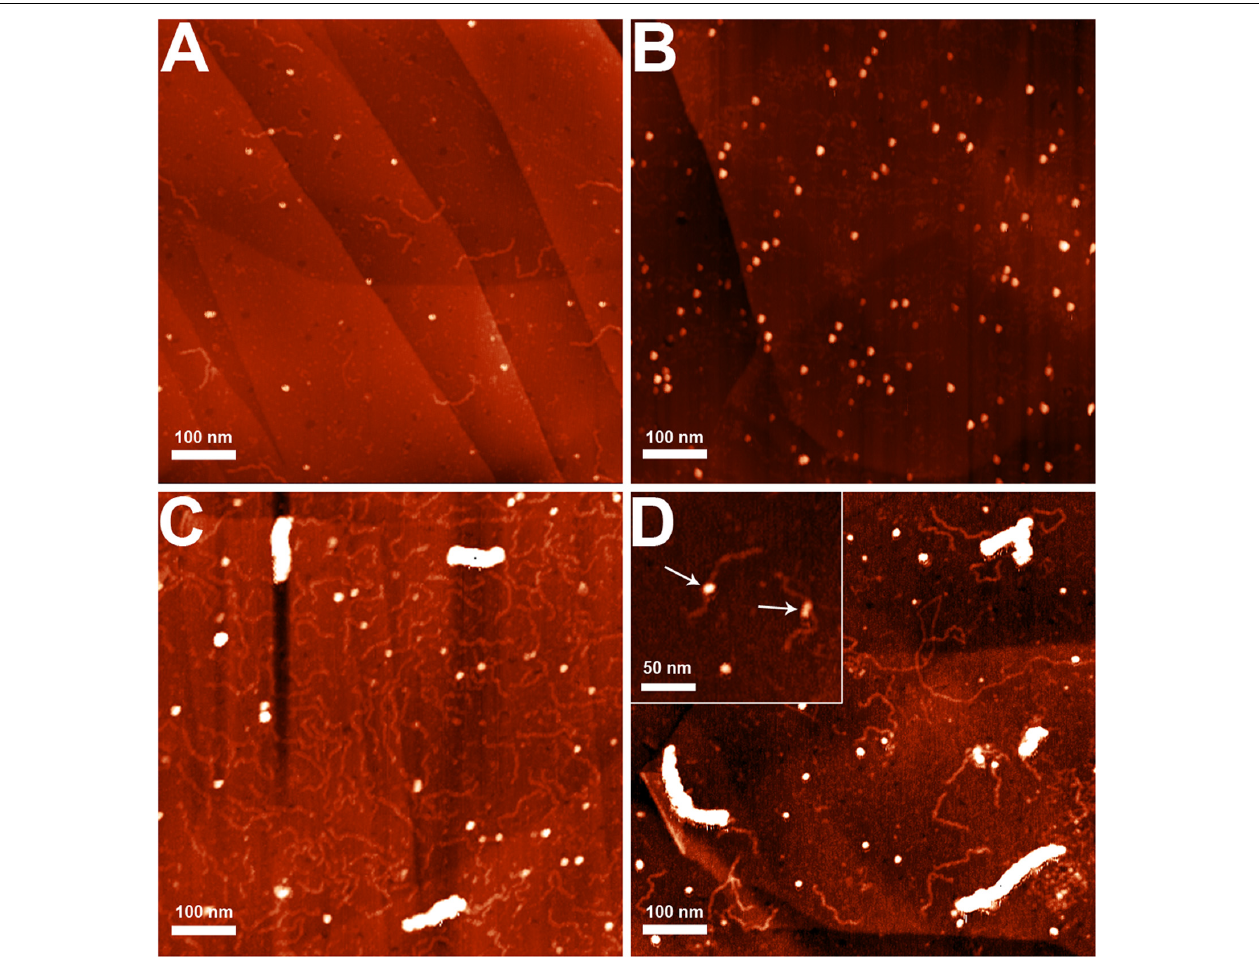
FIGURE 6 | (A) AFM images of P rplJ DNA fragment, corresponding to rplJ operon promoter, 300 bp, (B) recombinant enolase preparation, (C,D) high-molecular nucleoprotein complexes of enolase with DNA P rplJ fragment. Binding reaction was performed same as for EMSA. Panel (D) represents 9-fold dilution of DNA in comparison to panel (C) . The arrows indicate low-molecular complexes of DNA fragments with